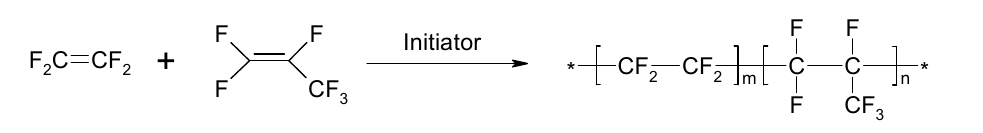
Figure 3. The preparation of